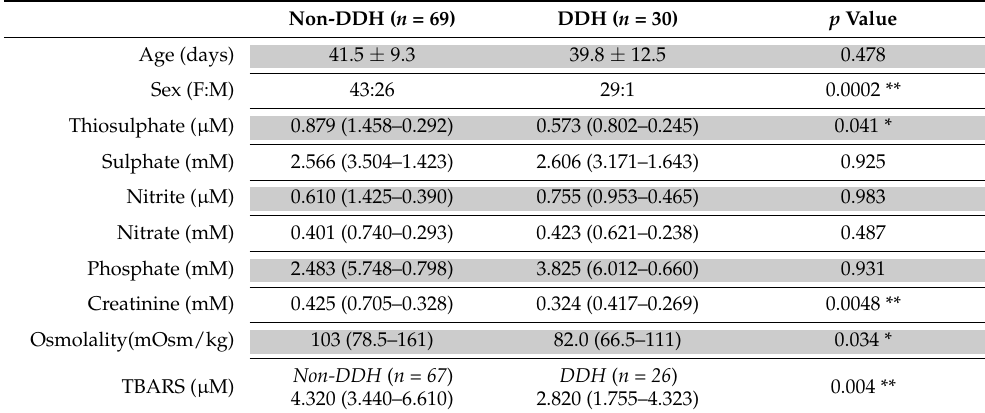
Table 1. Infant age and urine analyte concentrations. Age data (normal distribution) is shown as mean ± SD. Concentrations are given as median (interquartile range) as the data were log-normally distributed (non-parametric).